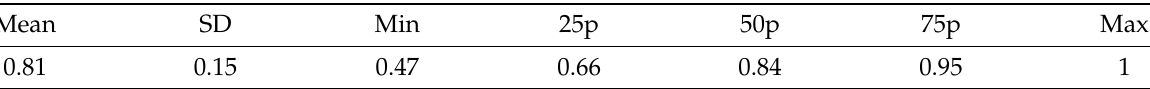
Table 3: Cramér’s V summary statistics